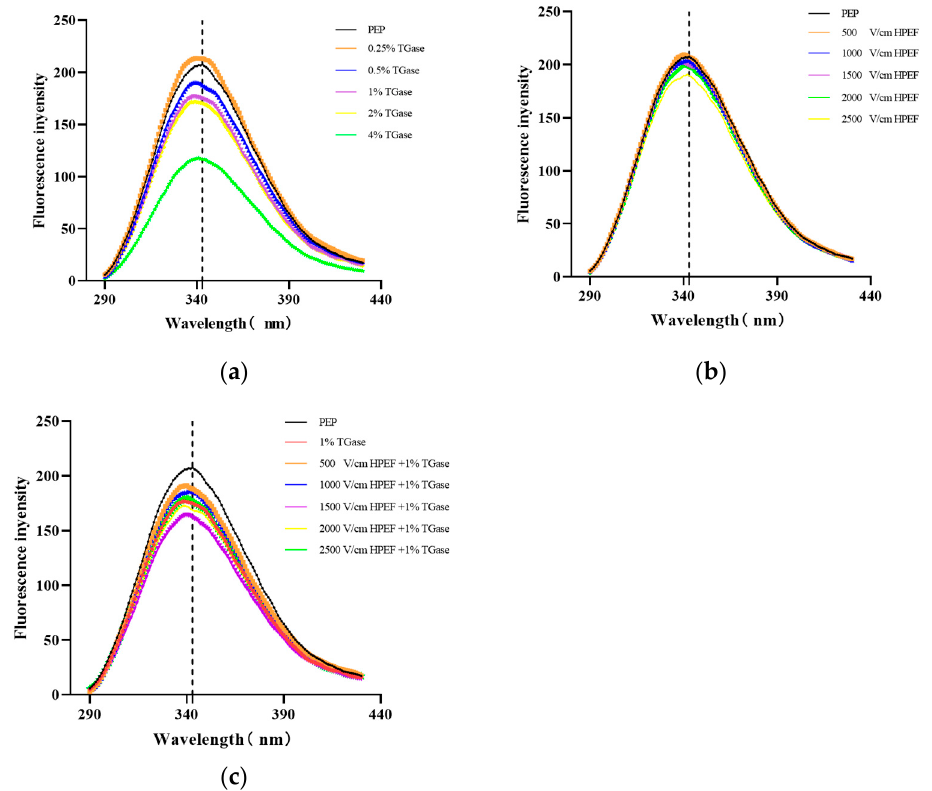
Figure 5. The effects of HPEF (500, 1000, 1500, 2000, and 2500 V/cm) addition, TGase (0.25, 0.5, 1, 2, and 4%), and compound treatment (HPEF-500, 1000, 1500, 2000, 2500 V/cm; 1% TGase) on the fluorescence spectrum of PEP. ( a ): Fluorescence spectrum of PEP treated with HPEF (500, 1000, 1500, 2000, and 2500 V/cm); ( b ): Fluorescence spectrum of PEP treated with TGase (0.25, 0.5, 1, 2, and 4%); ( c ): Fluorescence spectrum of PEP treated with HPEF and TGase (HPEF-500, 1000, 1500, 2000, 2500 V/cm; 1% TGase).